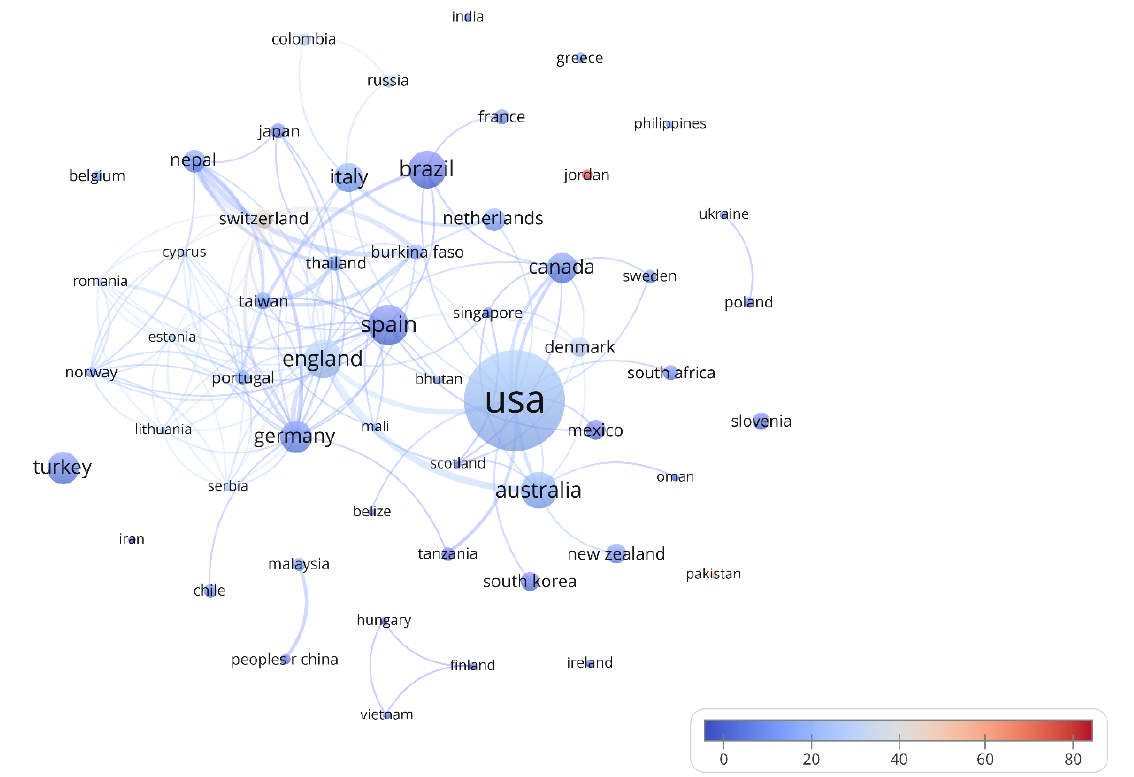
Figure 4. National/territorial co-authorship graph.